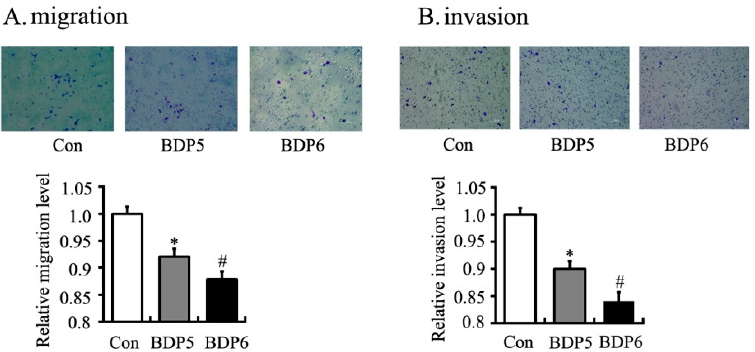
Figure 5. BPDs 5 and 6 decreased the migration and invasion of SMMC7721 cells. The cells were seeded in transwell upper chamber with ( B ) or without matrigel ( A ). After 24 h, the number of cells in the other side of membrane was determined by crystal staining and represented the mean ± SD ( n = 3). *, p < 0.05 compared with control group. #, p < 0.01 compared with 5 treatment.